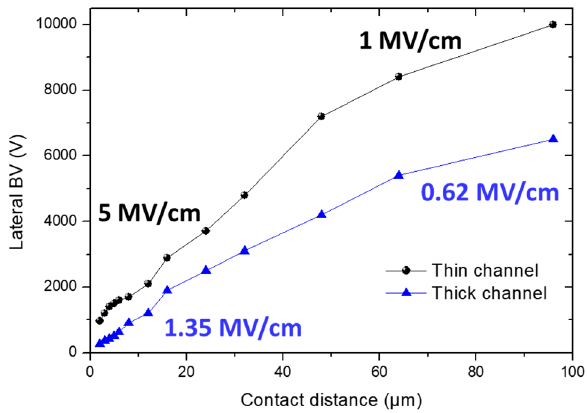
Figure 5. Lateral breakdown voltage at RT on isolated contacts with a 96 µm distance of thin and thick channel structures. The probes that were in a Fluorinert solution on top of the contacts are also shown.